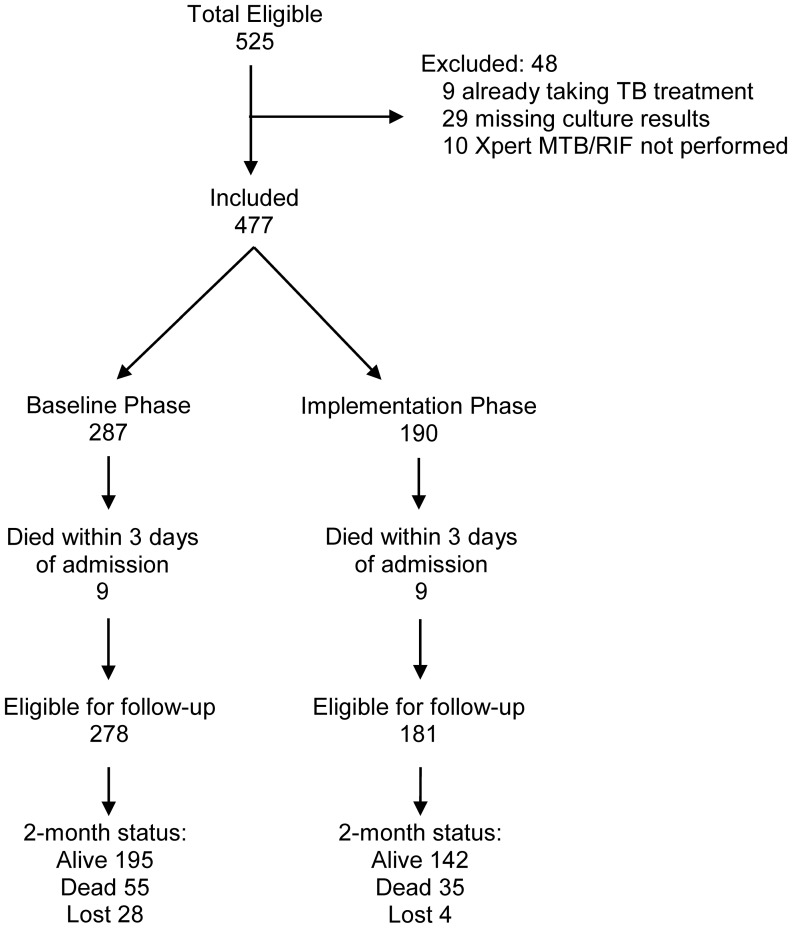
Study enrollment.Of 525 eligible patients, 477 (91%) were included in the study. 287 patients were enrolled during the initial baseline phase (Xpert MTB/RIF results not provided to clinicians during this validation phase) and 190 were enrolled during the implementation phase (Xpert MTB/RIF results provided to clinicians and used for patient management). Eighteen patients (nine in the baseline phase and nine in the implementation phase) died within three days of admission and were not included in survival analysis.